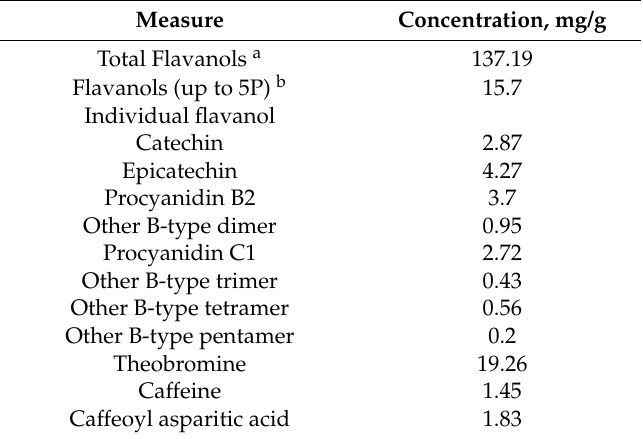
Table 1. Chemical composition of Acticoa cocoa